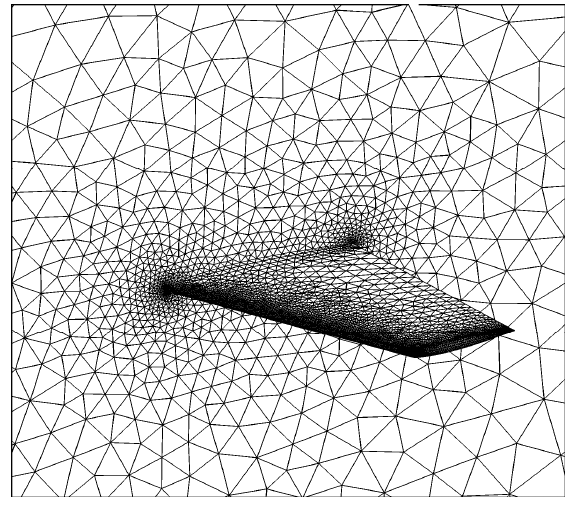
Figure 14. Meshes (wing surface, symmetric plane). In Figure 15, the obtained contours of the pressure coefficient on the surface of the wing are first presented for the mentioned transonic case, together with the isolines of the pressure coefficient in the symmetric plane, in order to have a global view of captured flow fields. The corresponding distributions of the surface pressure coefficient at six typical sections along the wingspan are also presented in Figure 16. It can be observed that the obtained results at the sections are all in a reasonable agreement with the numerical results [41] and experimental data [42] in view of the strength or location of the captured shock.